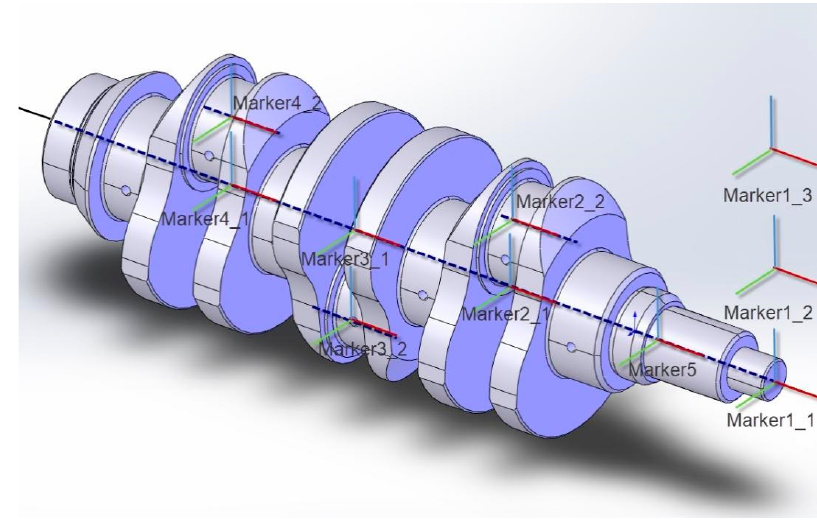
Figure 26. Test point arrangement.